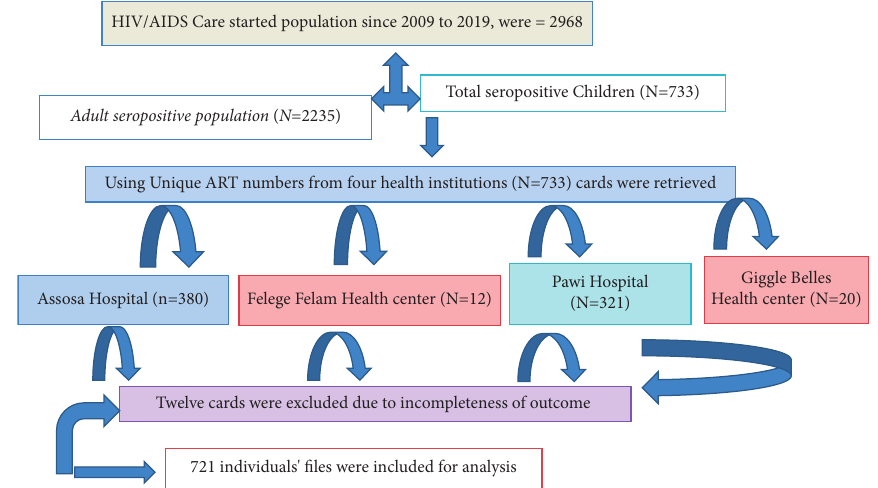
Figure 1: Schematic presentation sampling procedures for the study of seropositive